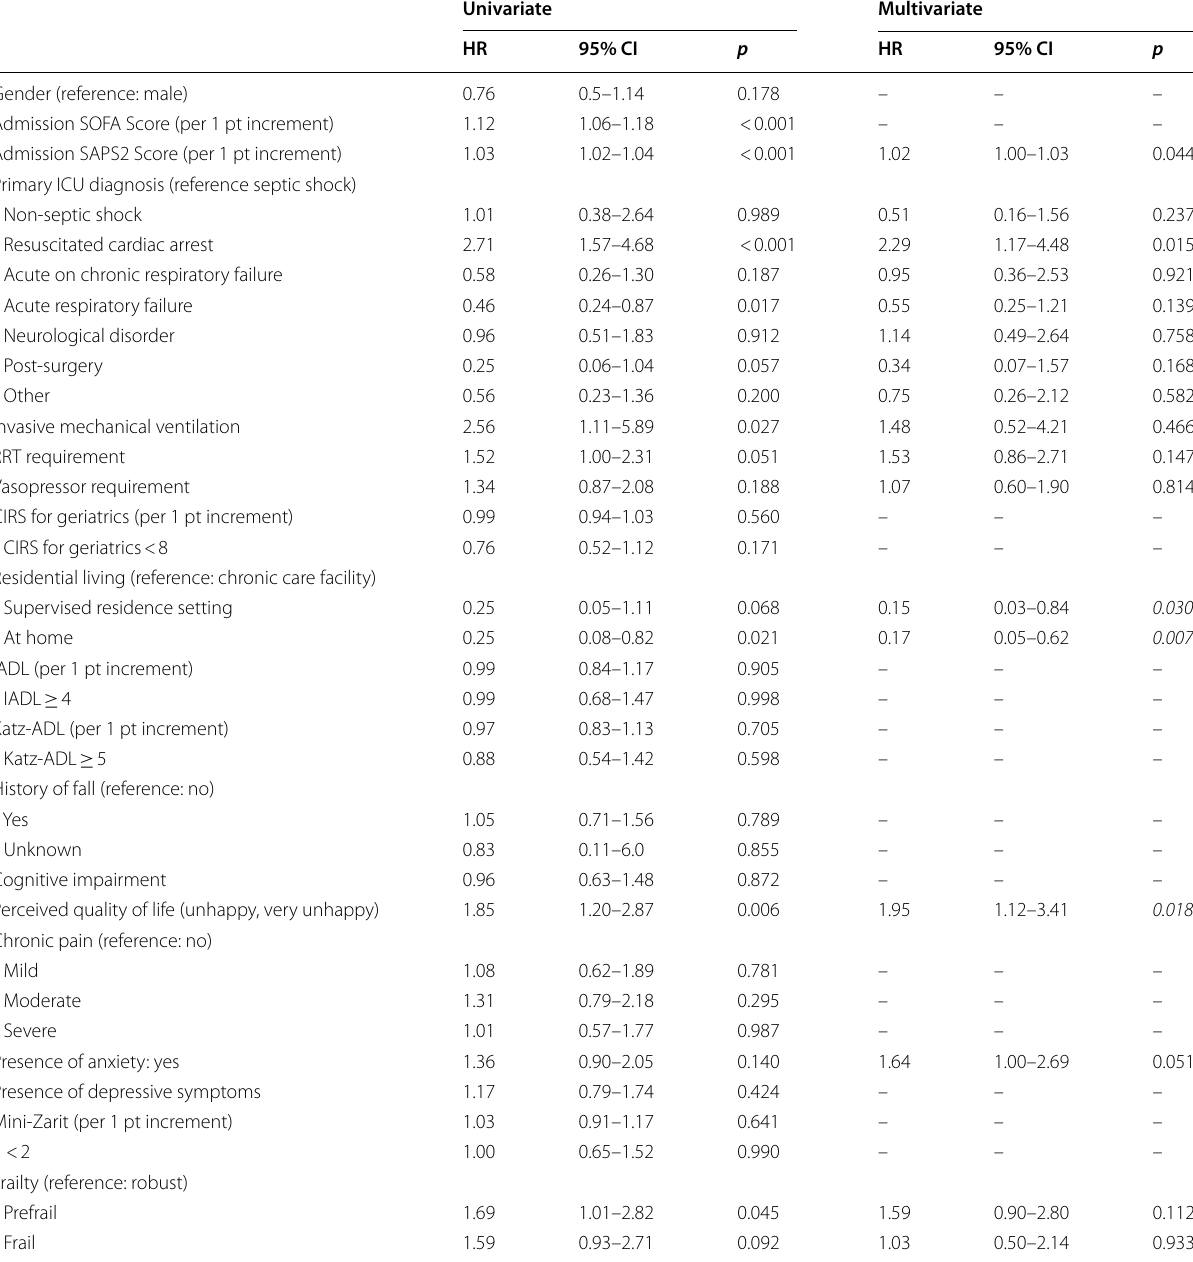
Table 4 Determinants associated with in-hospital mortality using Cox cause-specific